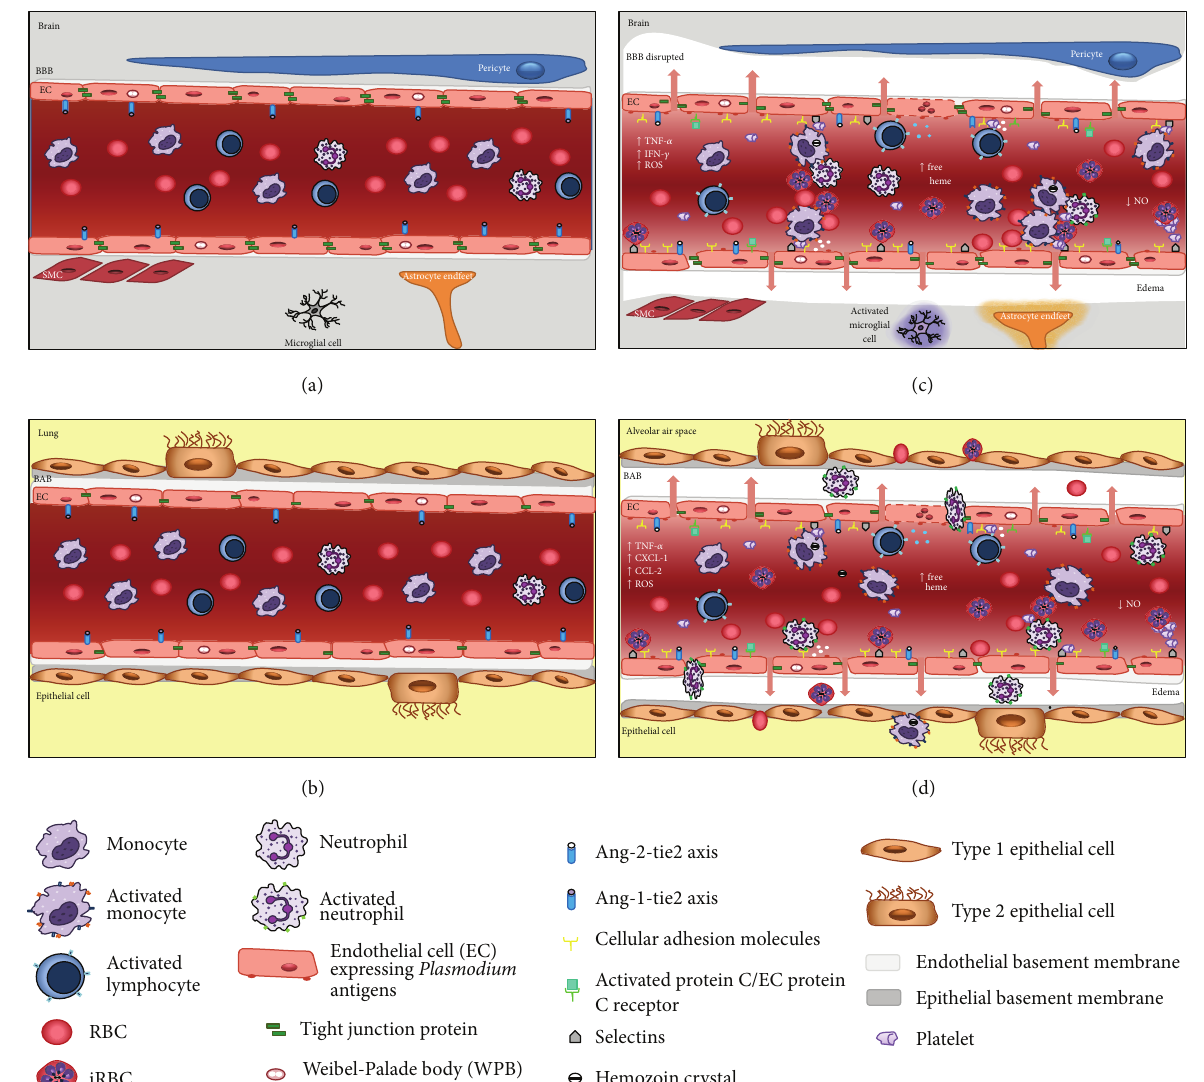
Figure 1: Blood barrier differences between brain and lung during malaria. (a) Cerebral microvasculature and (b) lung microvasculature without leucocytes attached in postcapillary venules and EC expressing Ang-1, under physiological conditions. (c) During severe malaria, we observe production of proinflammatory cytokines, increase of cellular adhesion molecules expression, release of Ang-2, decrease of NO, and adhesion of iRBC and leukocytes (mainly mononuclear cells) to brain vasculature leading to capillary congestion, BBB dysfunction, and edema. Such events activate the subjacent tissue (microglial cells and astrocytes). (d) Acute lung injury (ALI) and acute respiratory distress syndrome (ARDS) associated with malaria. The augment of inflammatory cytokines and chemokines, release of Ang-2, and decrease of NO are responsible for activation of EC that increases the expression of cellular adhesion molecules allowing the margination and infiltration of iRBC, leucocytes, and platelets into blood vessels, interstitial tissue, and consequently alveolar air space. BBB: blood-brain barrier; BAB: blood-air barrier; EC: endothelial cell; ROS: reactive oxygen species; SMC: smooth muscle